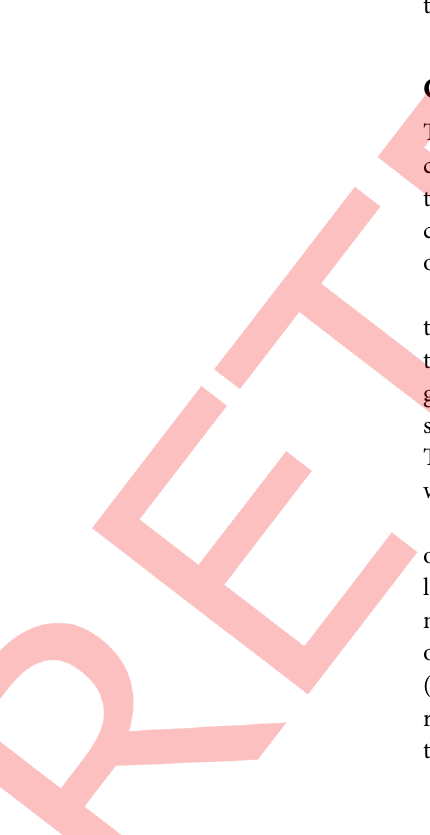
(Table 2). The GmSS13 shares less identity and similarity with all the other GmSS genes at pro- tein level (Table 2).